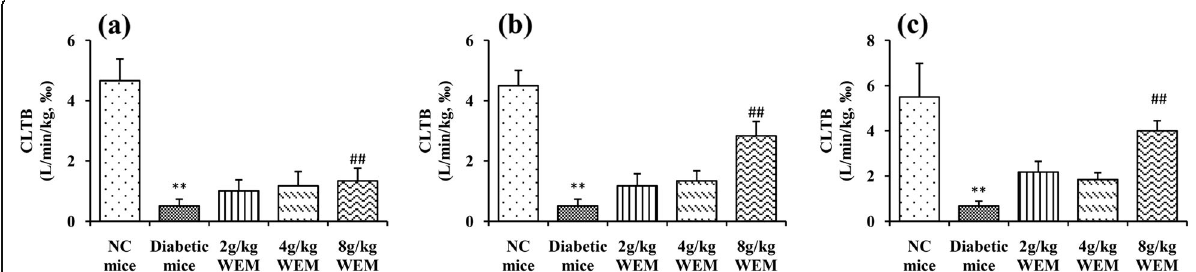
Fig. 4 Total body clearance (CLTB) of glucose was calculated using DAS software in the 6th ( a ), 8th ( b ) and 10th ( c ) week starting from the treatment. Results are means ± SEM ( n = 6). * P < 0.05, ** P < 0.01, NC mice vs. Diabetic mice; # P < 0.05, ## P < 0.01, WEM vs. Diabetic mice